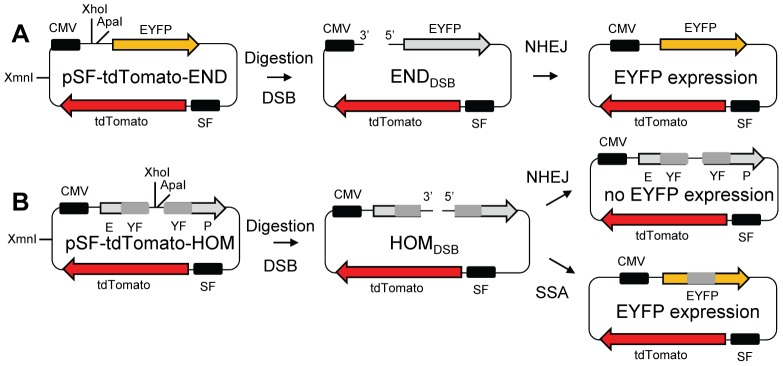
Host cell reactivation DSB repair assays.Test plasmids are digested in vitro with XhoI and ApaI, leading to a DSB with a 3' and a 5' overhang. Digested plasmids are transfected in cells and express tdTomato as a transfection marker and EYFP when DSB repair occurred. A functional EYFP gene is indicated in yellow. (A) pSF-tdTomato-END with a double-strand break leads to EYFP expression only after NHEJ repair restores the physical link between the gene and its CMV promoter. (B) pSF-tdTomato-HOM contains two incomplete copies of EYFP (one with the 5' and the other with the 3' part of the gene with a 355 bp overlap (grey boxes) between the two copies) resulting in a non functional gene. Repair of the DBS break in the HOM construct leads to a functional EYFP only if repair is done by SSA, any repair by NHEJ remaining undetected.